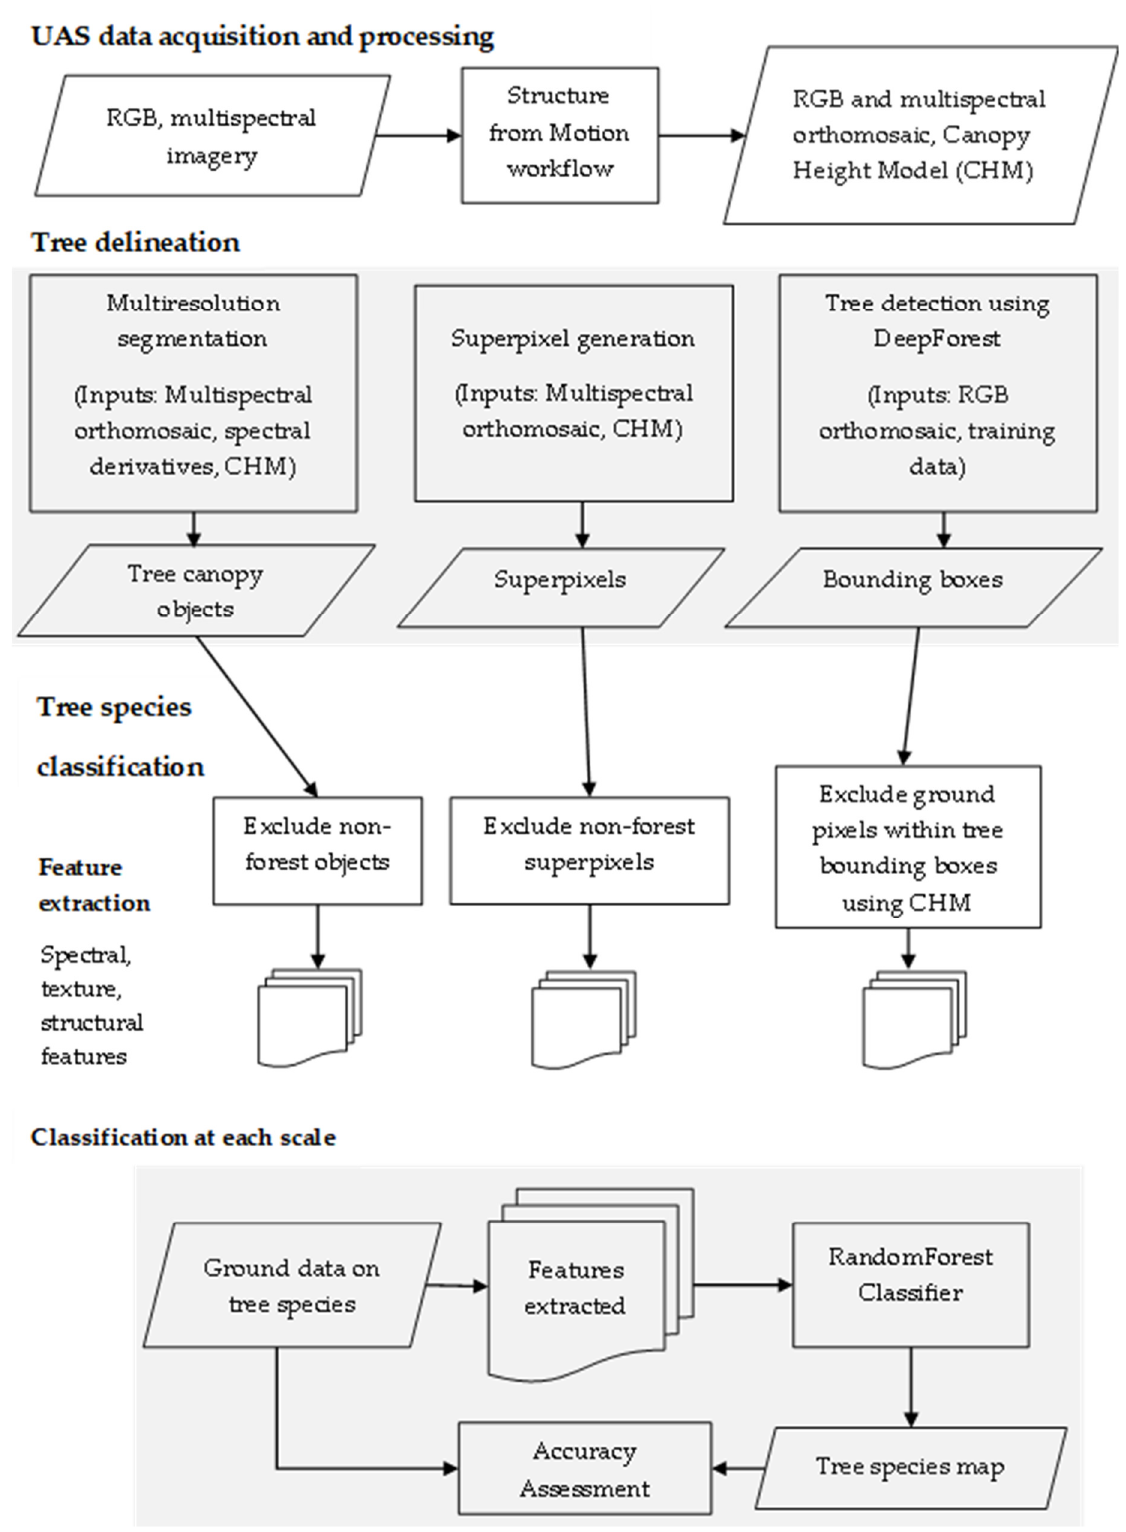
Figure 1. Flowchart of the workflow used for tree canopy delineation and tree species classification at the object, superpixel, and individual tree bounding box scales.